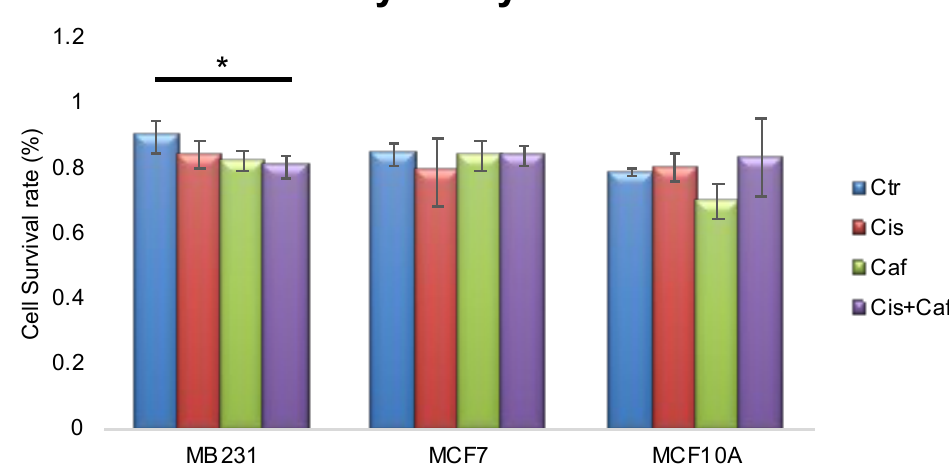
Figure 5. Cell viability assay demonstrates the cell survival rate for each treatment with MDA-MB-231, MCF7 and MCF10A cell lines. Star (*) indicates a significant difference with p -value <0.05.